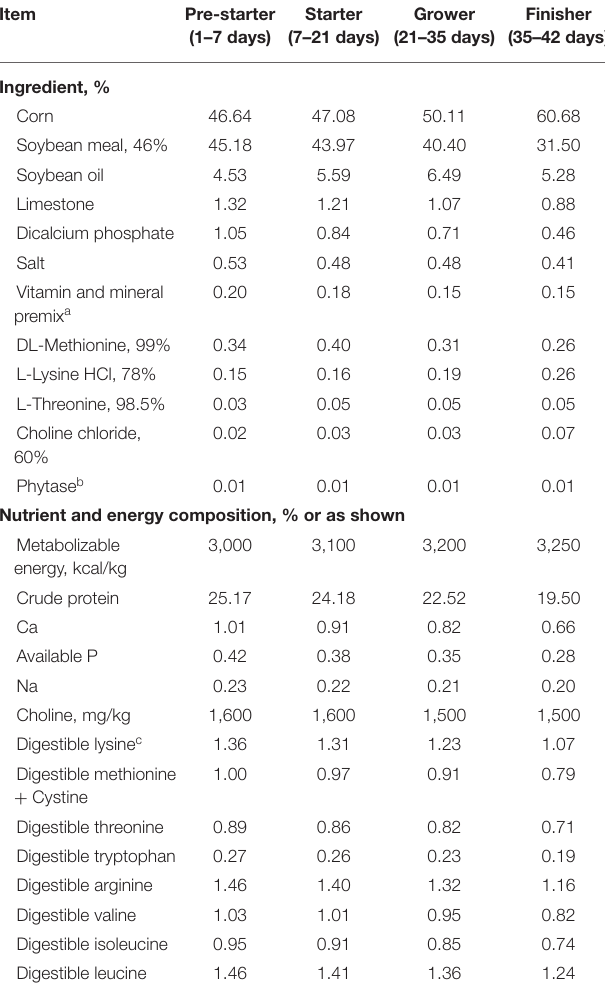
TABLE 1 | Ingredient and nutrient composition of the experimental diets, as fed basis.